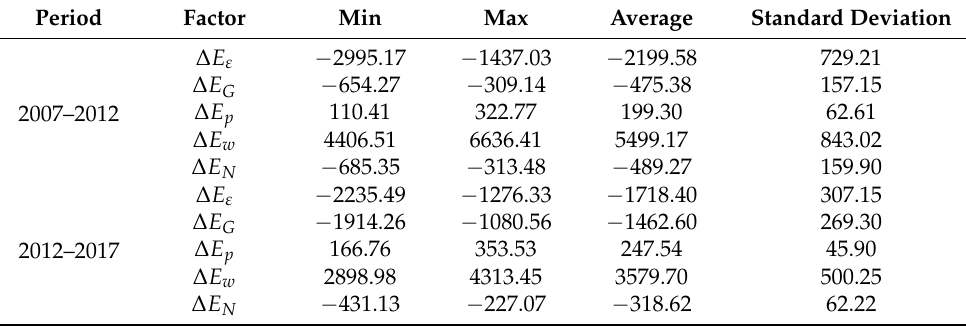
Table A3. Variability of the SDA outcomes of 120 different decomposition